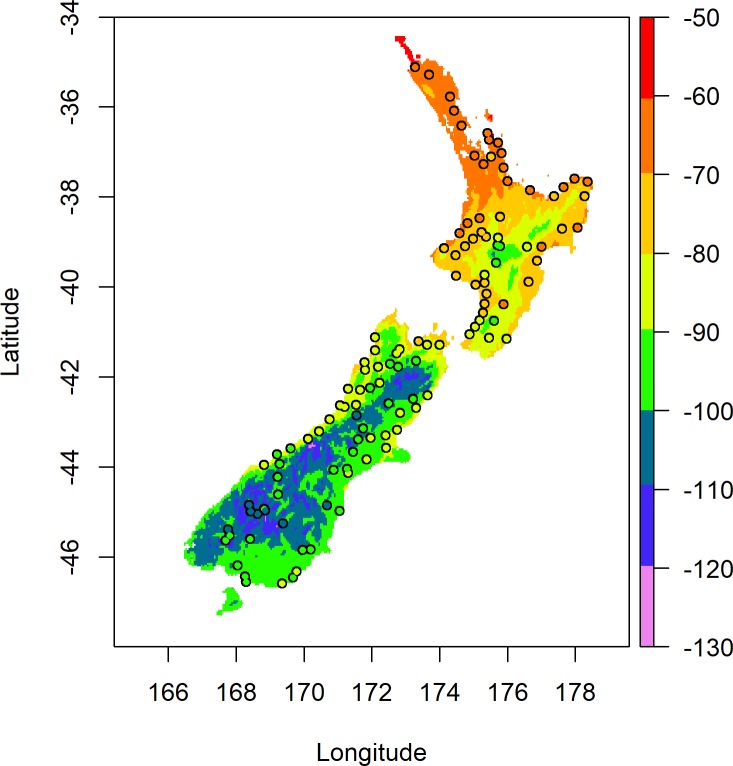
Predicted blackberry leaf δ2H values across New Zealand based on Model 2.Coloured points represent the measured δ2H values for blackberry leaves sampled from those locations.